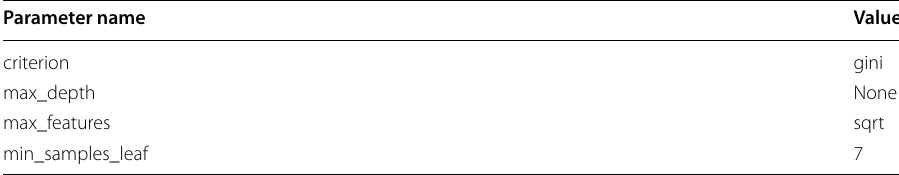
“None” value indicates default value of hyperparameter is optimal; parameter values for classifier yielding best results in terms of